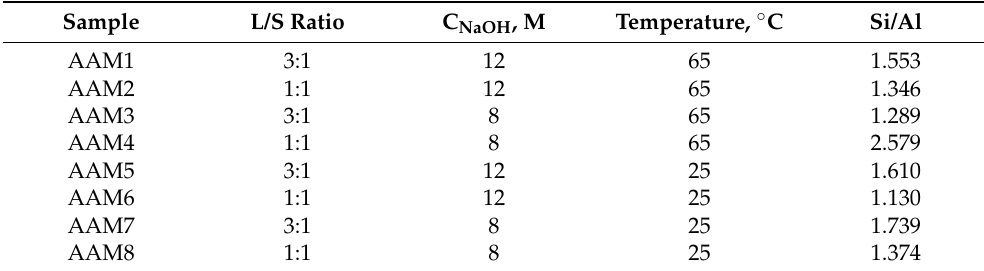
Table 1. The materials selected for